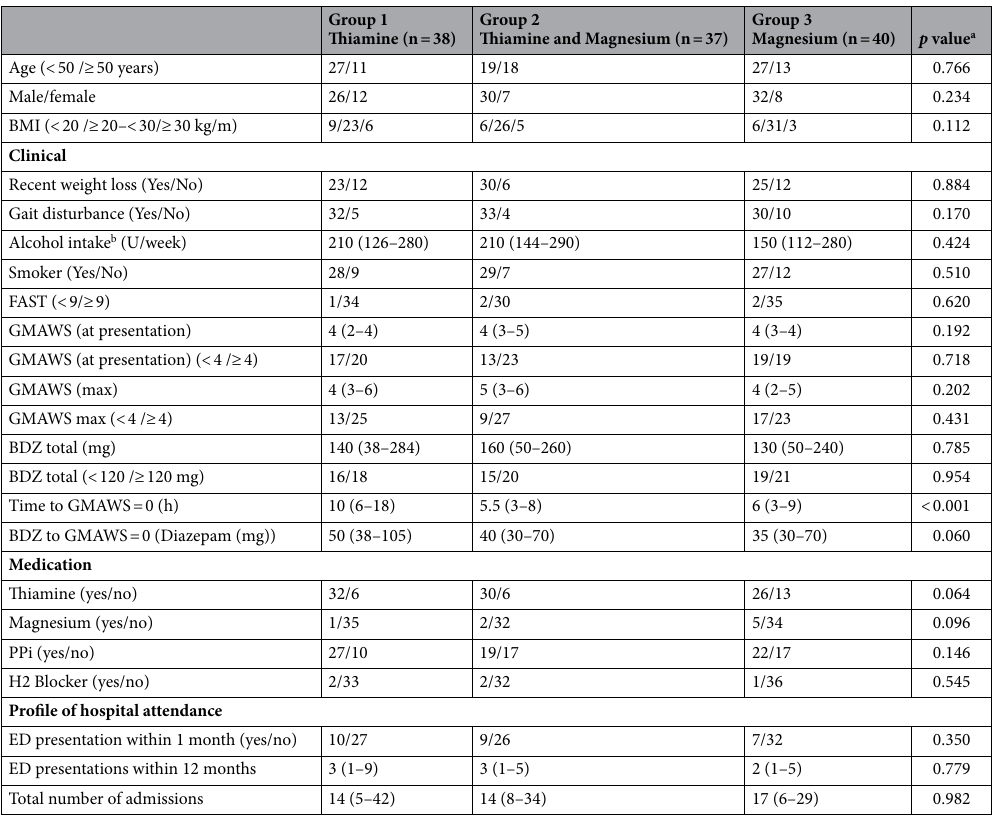
Table 1. Baseline characteristics of patients recruited to the randomised controlled trial (n = 115). Continuous data are presented as median and interquartile range (parentheses). a Categorical and continuous data were analysed with Chi-squared and Kruksall-Wallis tests respectively. b Group 1: n = 19; Group 2: n = 16; Group 3: n =